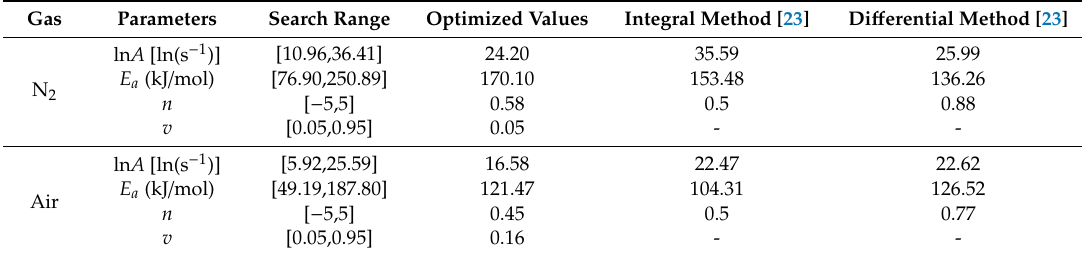
Table 5. Optimized parameters and searing range by particle swarm optimization (PSO) on three heating